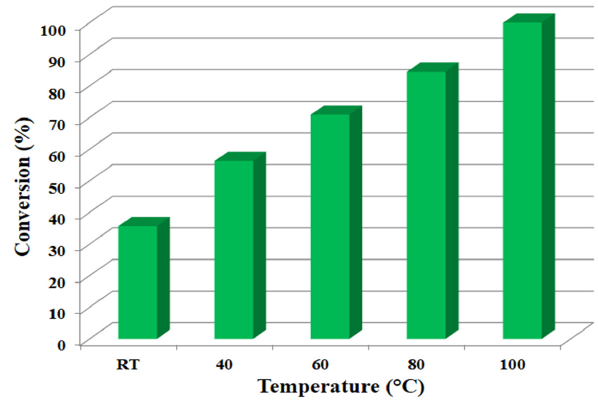
Table 3. Reaction temperature optimization.